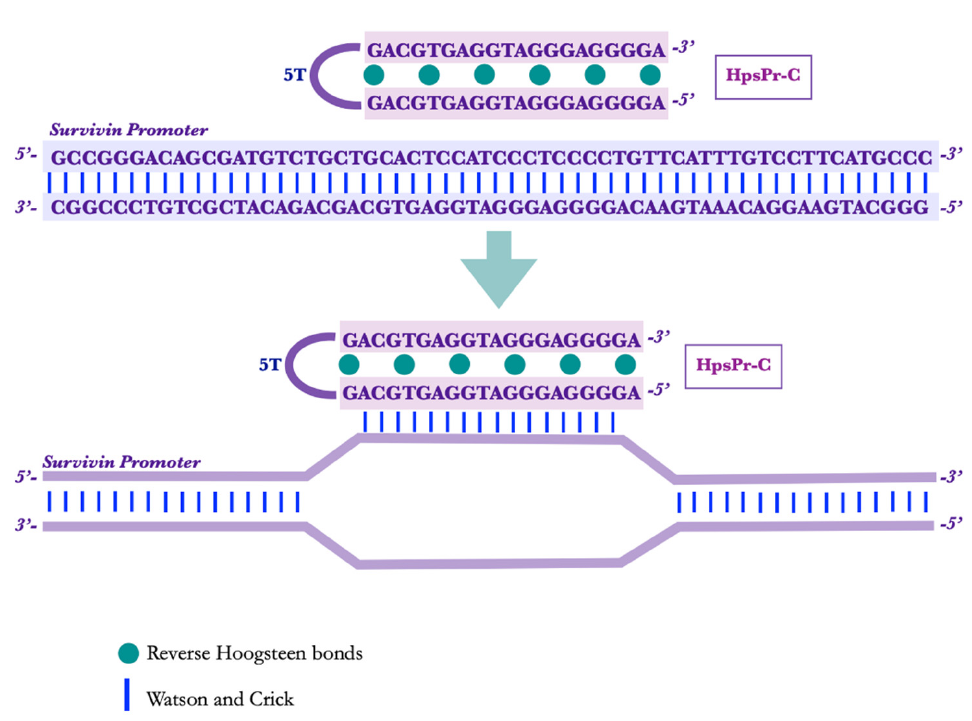
Figure 1. HpsPr-C scheme of action. The PPRH directed against the promoter of the survivin gene (HpsPr-C) binds to a polypyrimidine stretch found in the coding strand of the gene, forming a triplex structure and displacing the reverse strand in that region, resulting in an inhibition of the transcription process.